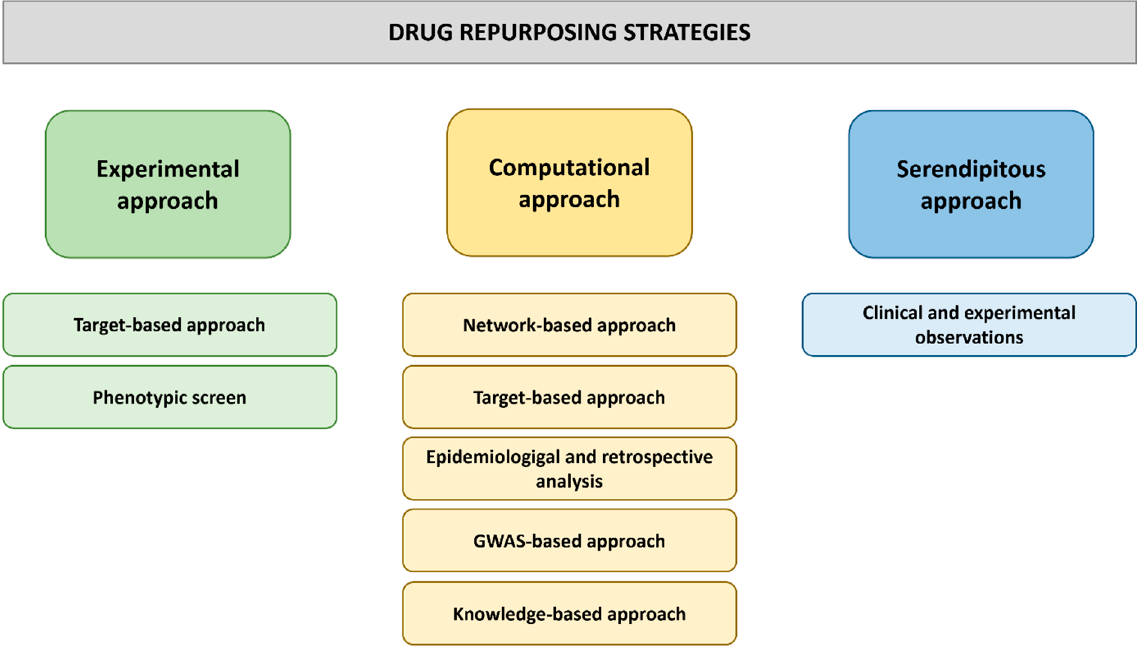
Figure 4. Drug repurposing approaches. Different experimental, computational and serendipitous strategies can be employed to identify promising drug repurposing candidates among existing drugs. This figure was generated with Powerpoint.